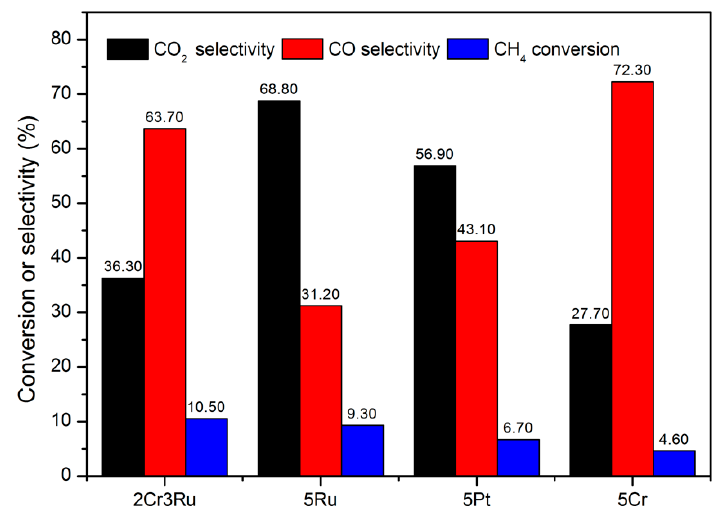
Figure 2. Activities of 2Cr3Ru/Al 2 O 3 , 5Pt/Al 2 O 3 , 5Ru/Al 2 O 3 , and 5Cr/Al 2 O 3 . Reaction conditions: feed gas O 2 /CH 4 volume ratio = 3/5, GHSV = 15,000 h − 1 , and reactor temperature = 475 °C. The total metal loading of active metals on Al 2 O 3 was fixed at 5 wt%.